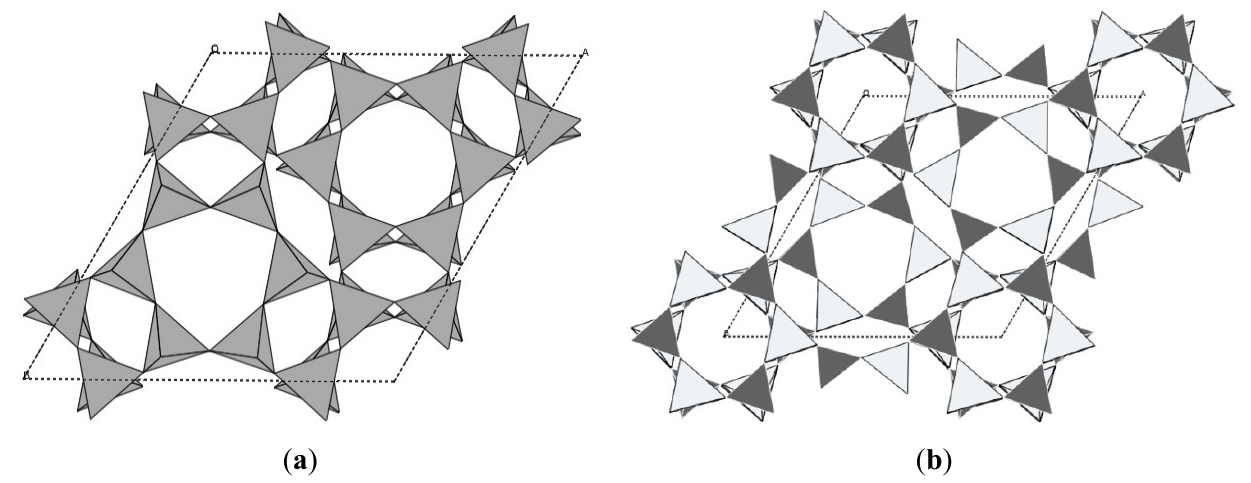
Figure 7. Crystal structures of ( a ) chabazite; ( b )